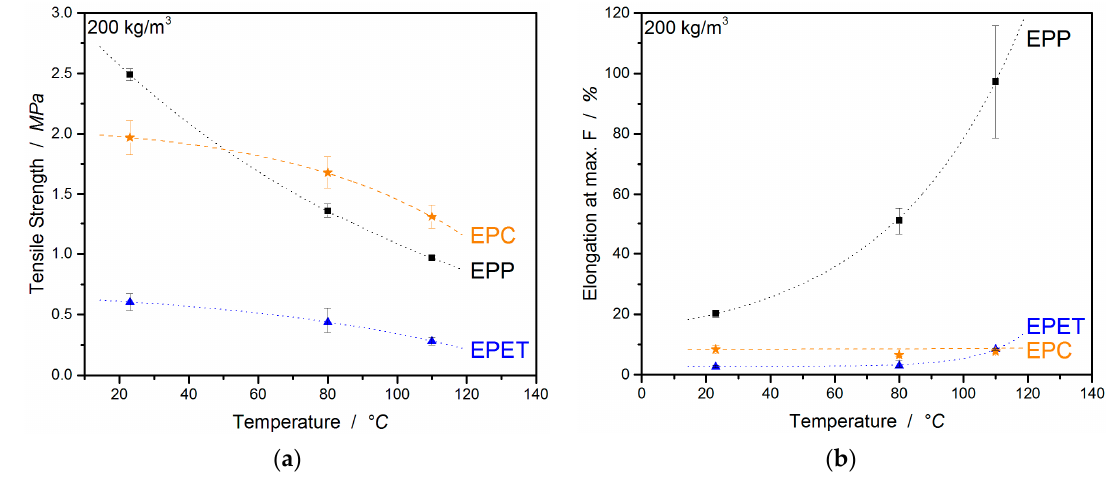
Figure 8. Tensile strength ( a ) and elongation at max Force ( b ) of EPC, EPP, and EPET at 25, 80, and 110 °C.